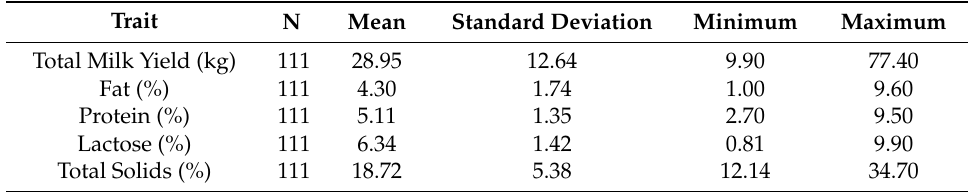
Table 2. Descriptive statistics of ewe milk traits.